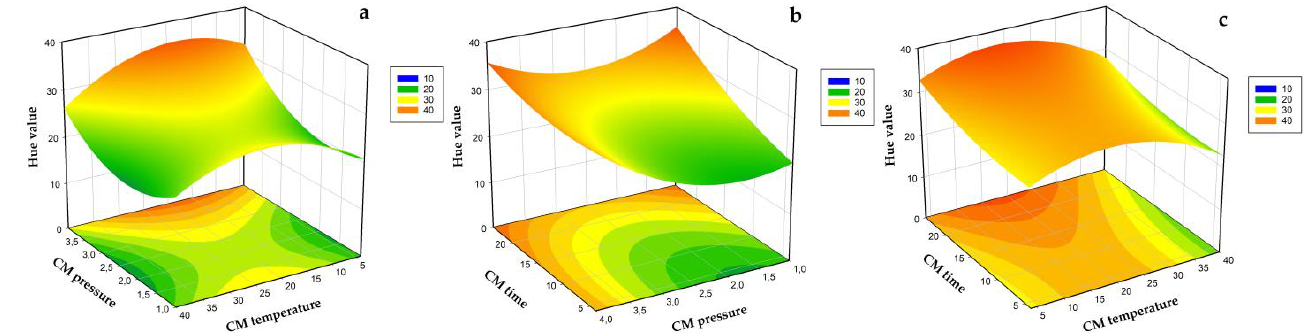
Figure 6. Influence of ( a ) CM pressure (bar) and CM temperature (°C), ( b ) CM time (h) and CM pressure (bar), and ( c ) CM time (h) and CM temperature (°C) on hue value of dried strawberries with CM pre-treatment.